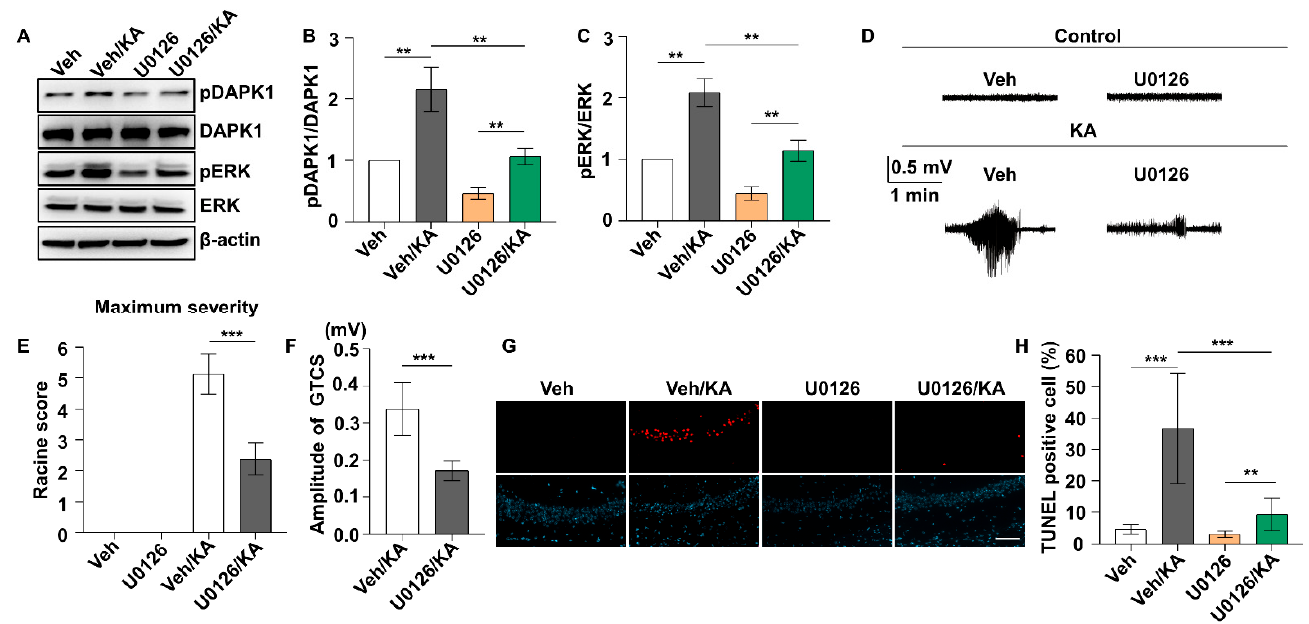
Figure 2. U0126 reduces DAPK1 phosphorylation, seizure severity, and neuronal cell death. Elec- trodes were implanted into mice (C57BL/6, male/female, 8–12 weeks, n = 10/group), which were allowed to recover for 7 days. The mice were treated with the specific ERK inhibitor, U0126 (25 mg/kg, i.p.), or the corresponding vehicle for 180 min before KA insult. Hippocampal tissues were dissected from a number of animals ( n = 4) 30 min after KA insult for immunoblotting analysis, and EEG traces and behavioral analysis were performed continuously in the remaining mice for 120 min. brain lysates were resolved on SDS-PAGE gels and then subjected to immunoblotting assays using anti-pSer735-DAPK1, anti-DAPK1, anti-pThr202/Tyr204 ERK, anti-ERK, or anti- β -actin antibodies